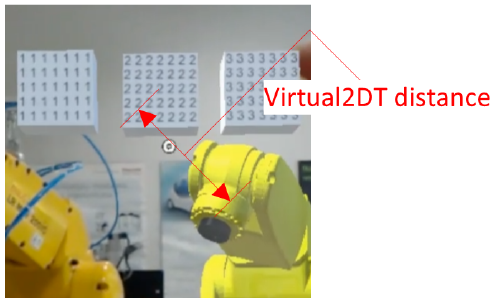
Figure 13. Visualization of the measurement between a virtual point and a point on the virtual representation of the robot